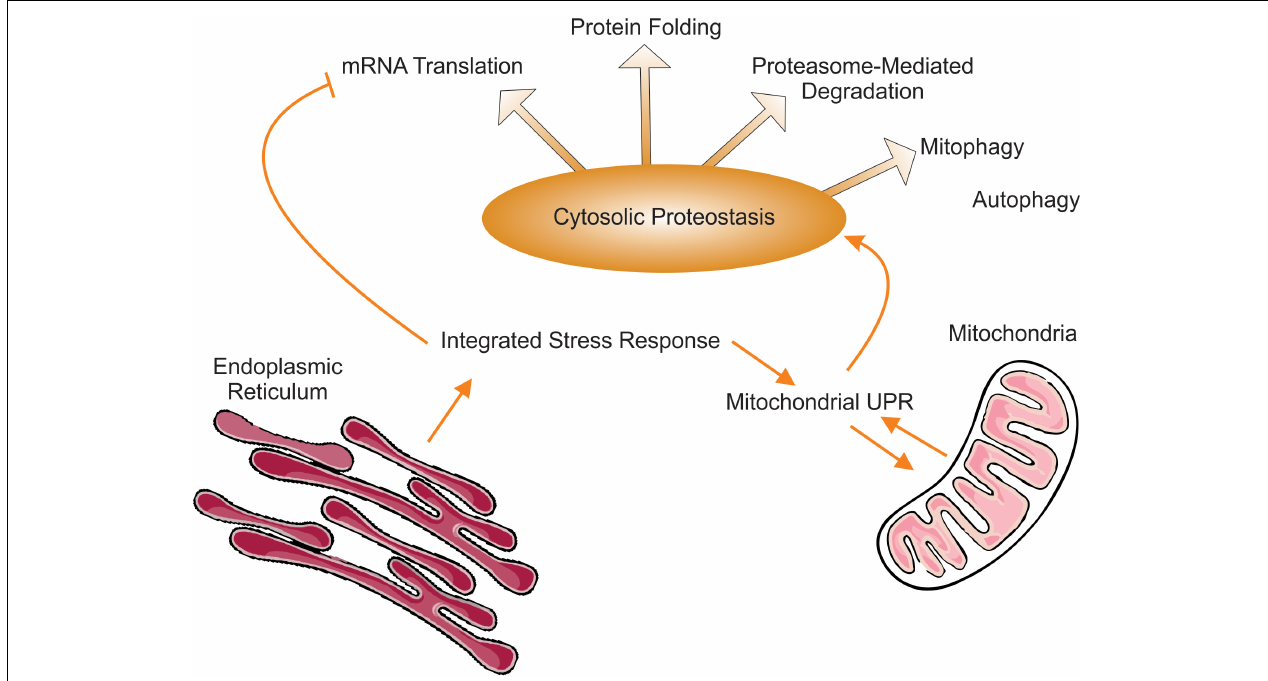
FIGURE 1 | Schematic representation of the interactions between integrated stress response, the mitochondrial UPR and cytosolic proteostasis. Of note, while autophagy represents an important aspect of cytosolic proteostasis, to our knowledge mitochondrial stress and the UPR mt activates mitophagy specifically but not the elimination of protein aggregates by